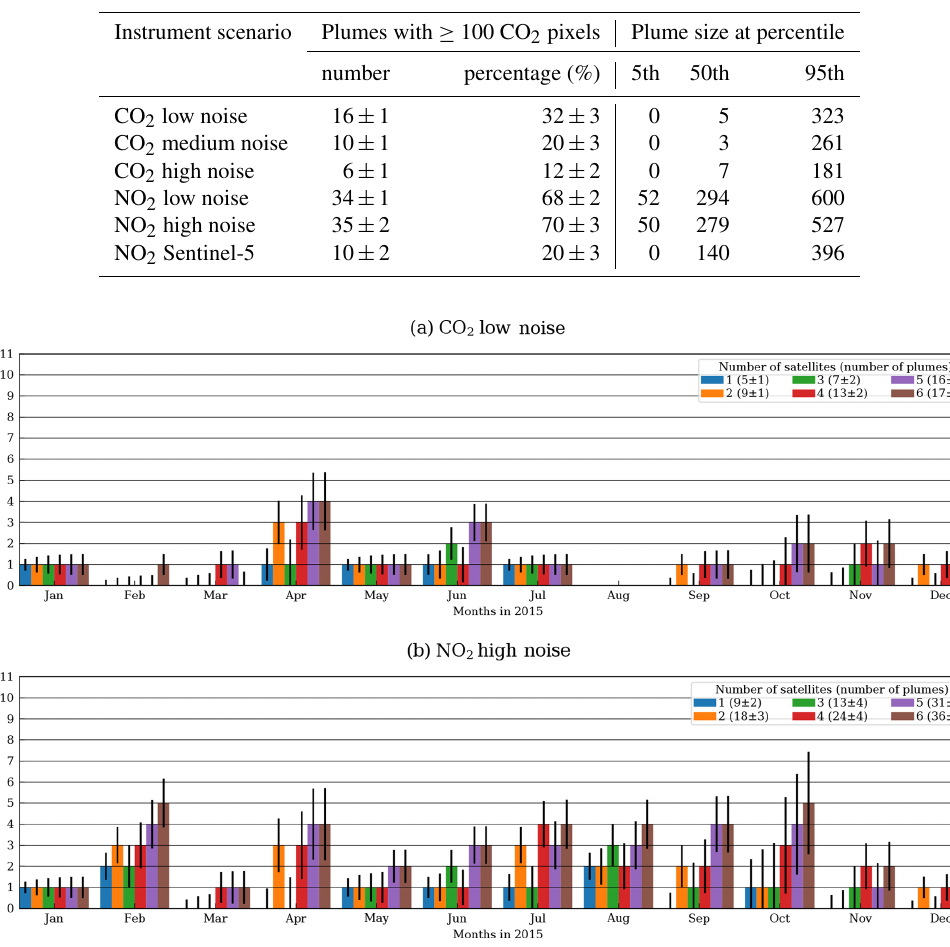
Table 7. Number of CO 2 plumes from Berlin and the 5th, 50th and 95th percentiles of the number of detected CO 2 pixels (TP if PPV ≥ 0.8 and cloud fraction < 1%) for a constellation of six CO2M satellites or one Sentinel-5 satellite. The maximum number of detectable plumes would be 50, corresponding to all potentially useful plumes with at least 100 CO 2 pixels with values of the tracer X BER above a threshold of 0.05ppm.